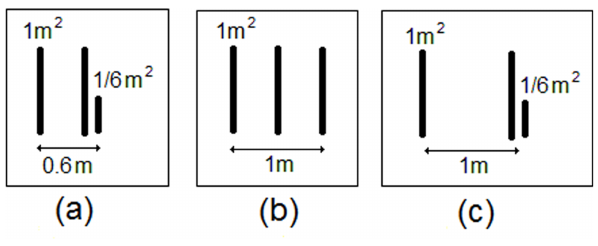
Fig. 1. Schematic view of the three Grotte Taillerie setups: (a) January–April 2011, (b) April–May 2011, and (c) May– July